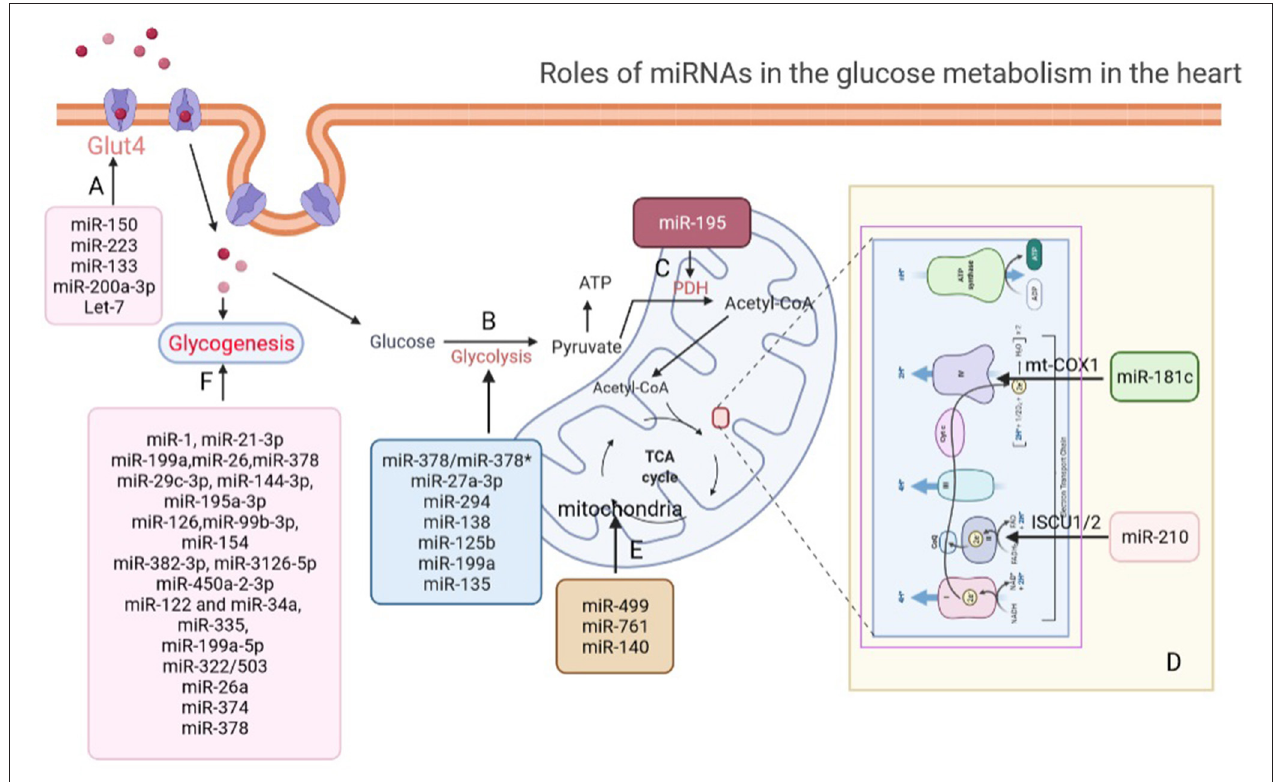
FIGURE 1 | Roles of miRNAs in glucose metabolism in the heart. (A) miRNAs regulate glucose transport via modulating the expression of GLUT4 in the heart. (B) miRNAs participate in glycolysis regulation in the heart. (C) miR-195 increased acetylation of PDH to promote pyruvate and NAD + convert into acetyl-CoA. (D) miR-181c and miR-210 involve in electron chain complex remodeling in cardiomyocytes by targeting and suppressing mt-COX1 and ISCU1/2. (E) miR-499, miR-761, and miR-140 regulate aerobic glucose oxidation by directly affecting mitochondrial function in the heart. (F) miRNAs regulate glycogenesis in the heart. GLUT4, glucose transporter type 4; PDH, pyruvate dehydrogenase complex; mt-COX1, cytochrome c oxidase subunit 1; ISCU1/2, iron-sulfur cluster assembly